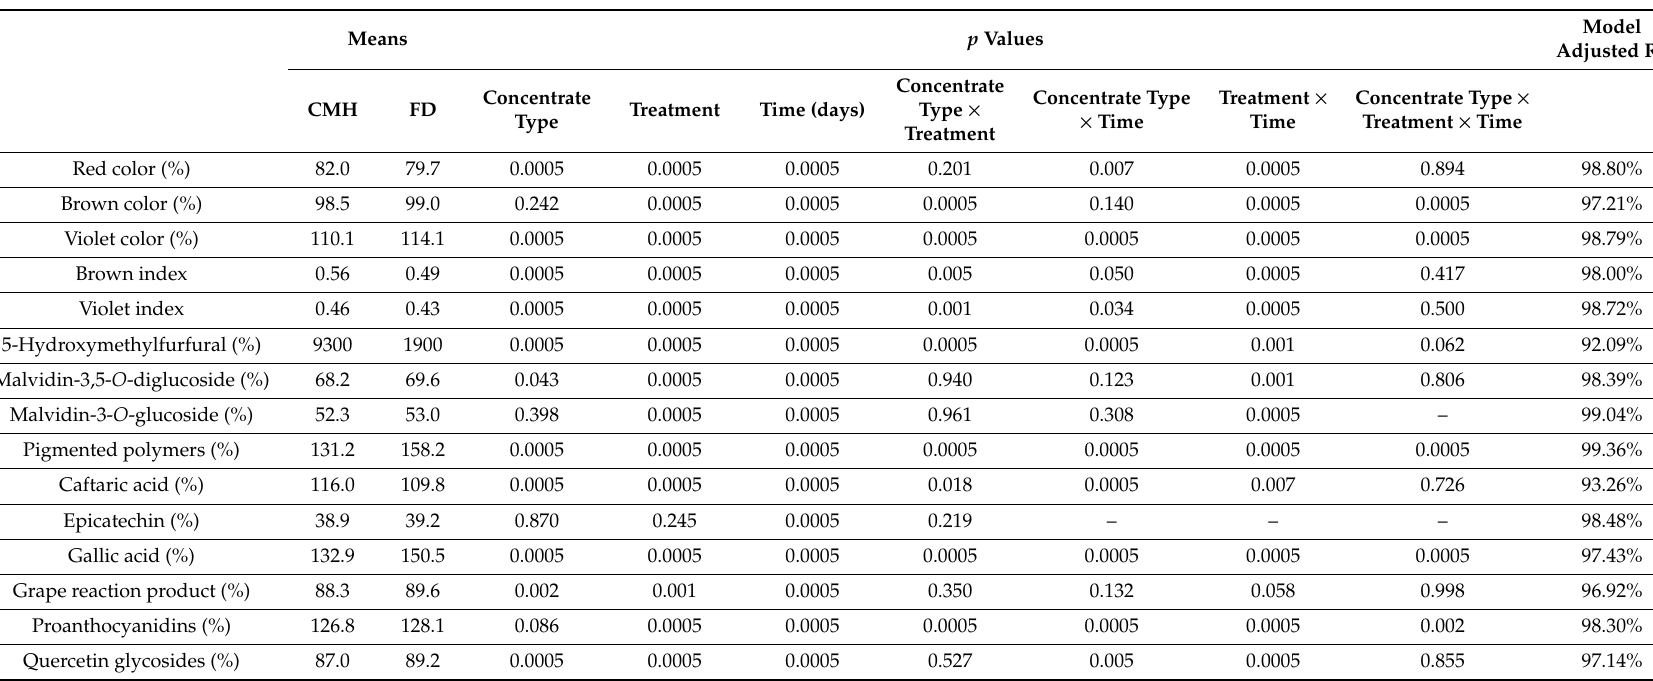
Table 2. Change in chemical composition relative to initial values of concentrate derived from commercial must heating (CMH) vs. flash d é tente (FD) after nine days of accelerated aging (at 50 ◦ C) and p values from repeated measures